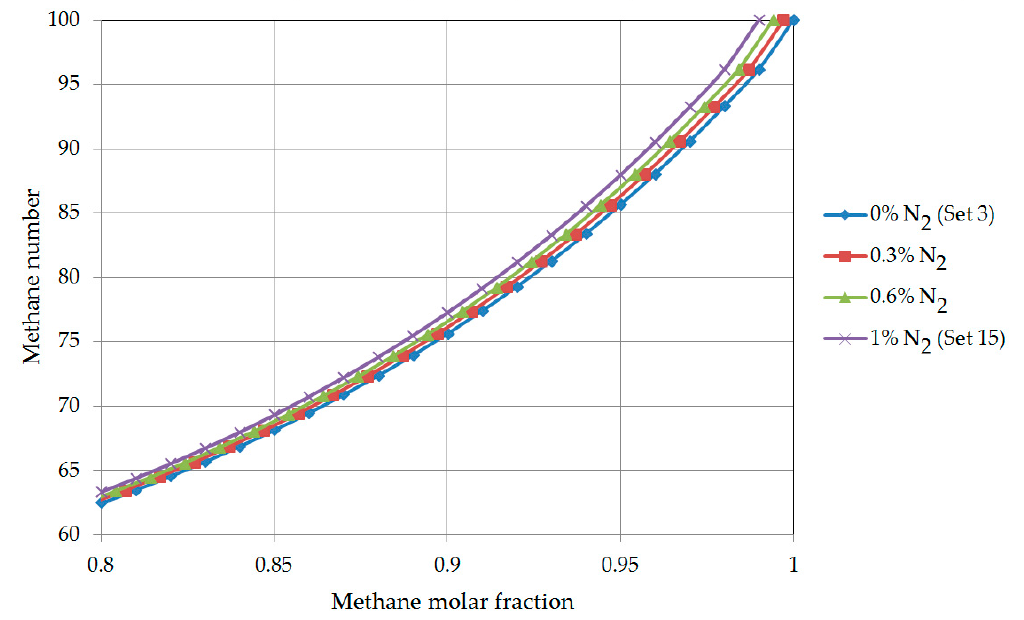
Figure 14. Methane number as function of methane molar fraction for composition sets which contains nitrogen.